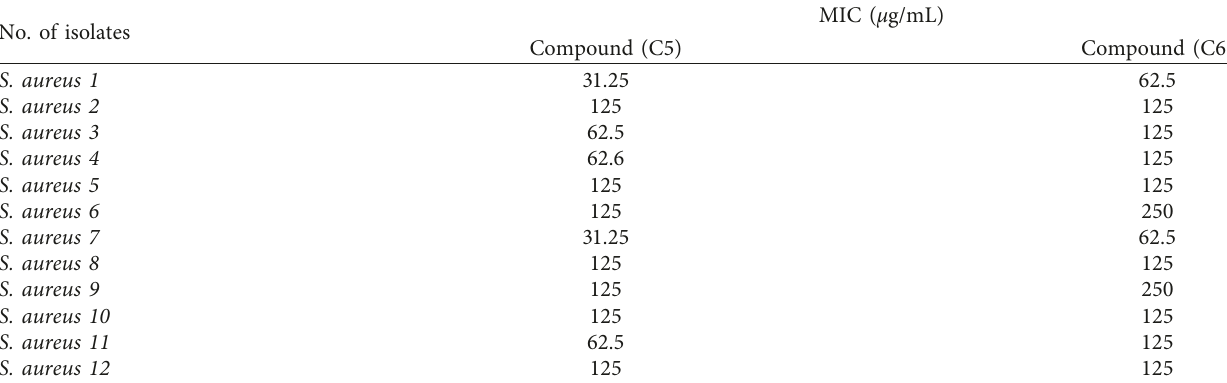
Table 8: MIC values of the new hydantoin compounds, C5 and C6, against the 12 virulent S. aureus isolates.